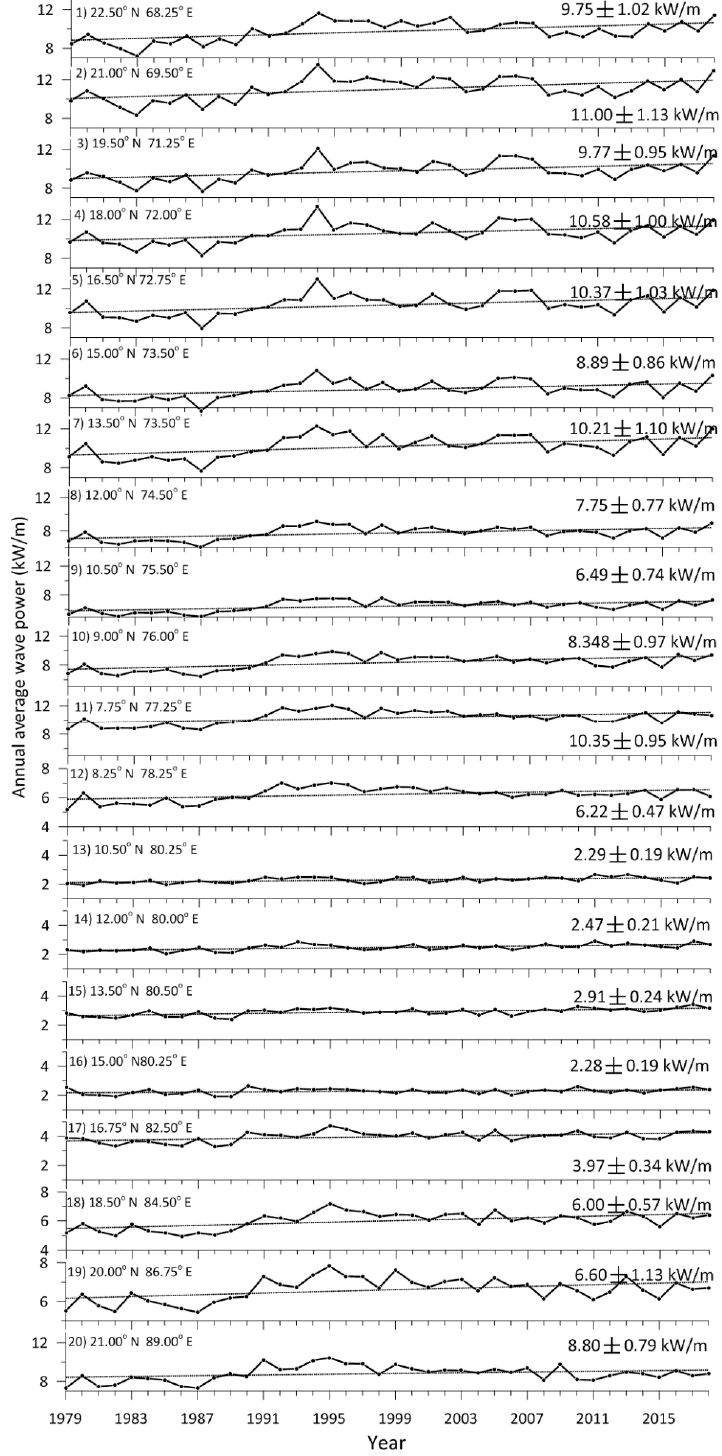
Figure 8. Long-term change in annual mean wave power from 1979 to 2018 at the 20 locations. The annual average value and the standard deviations are also presented.